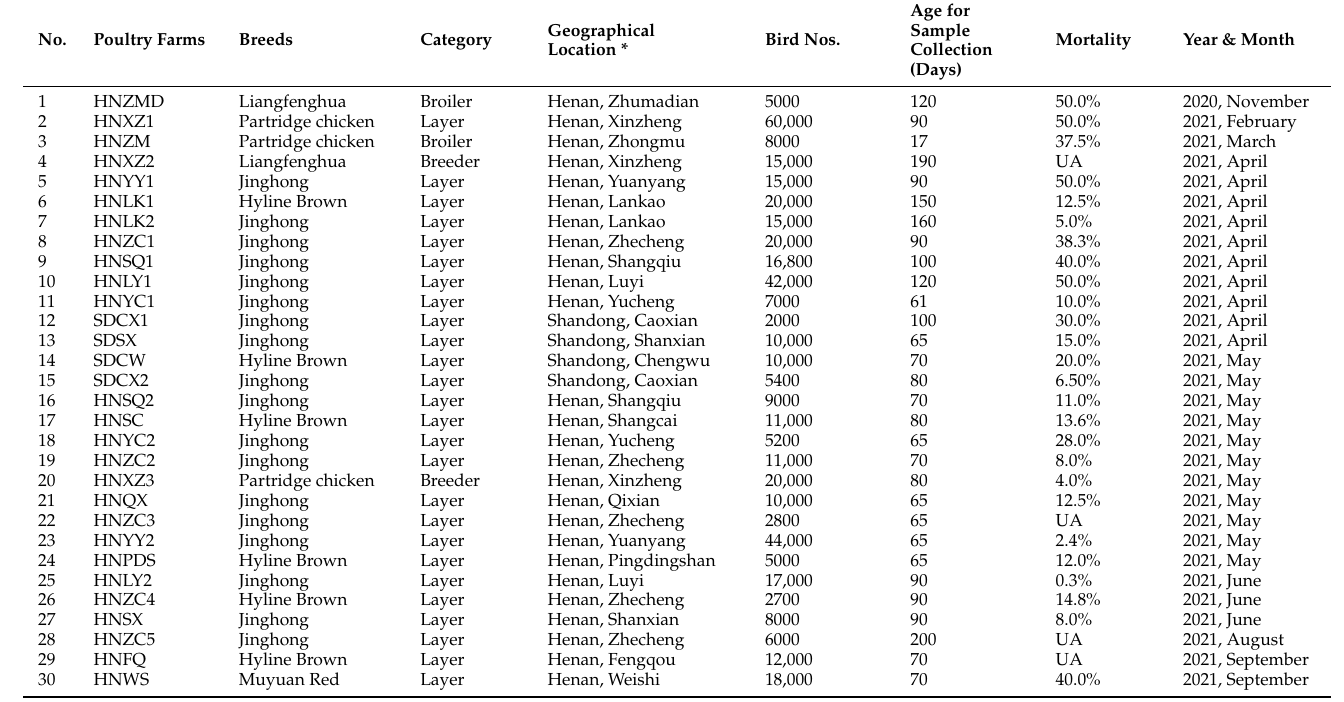
Table 1. Background of clinical cases of avian neoplastic diseases from poultry farms distributed in central China.